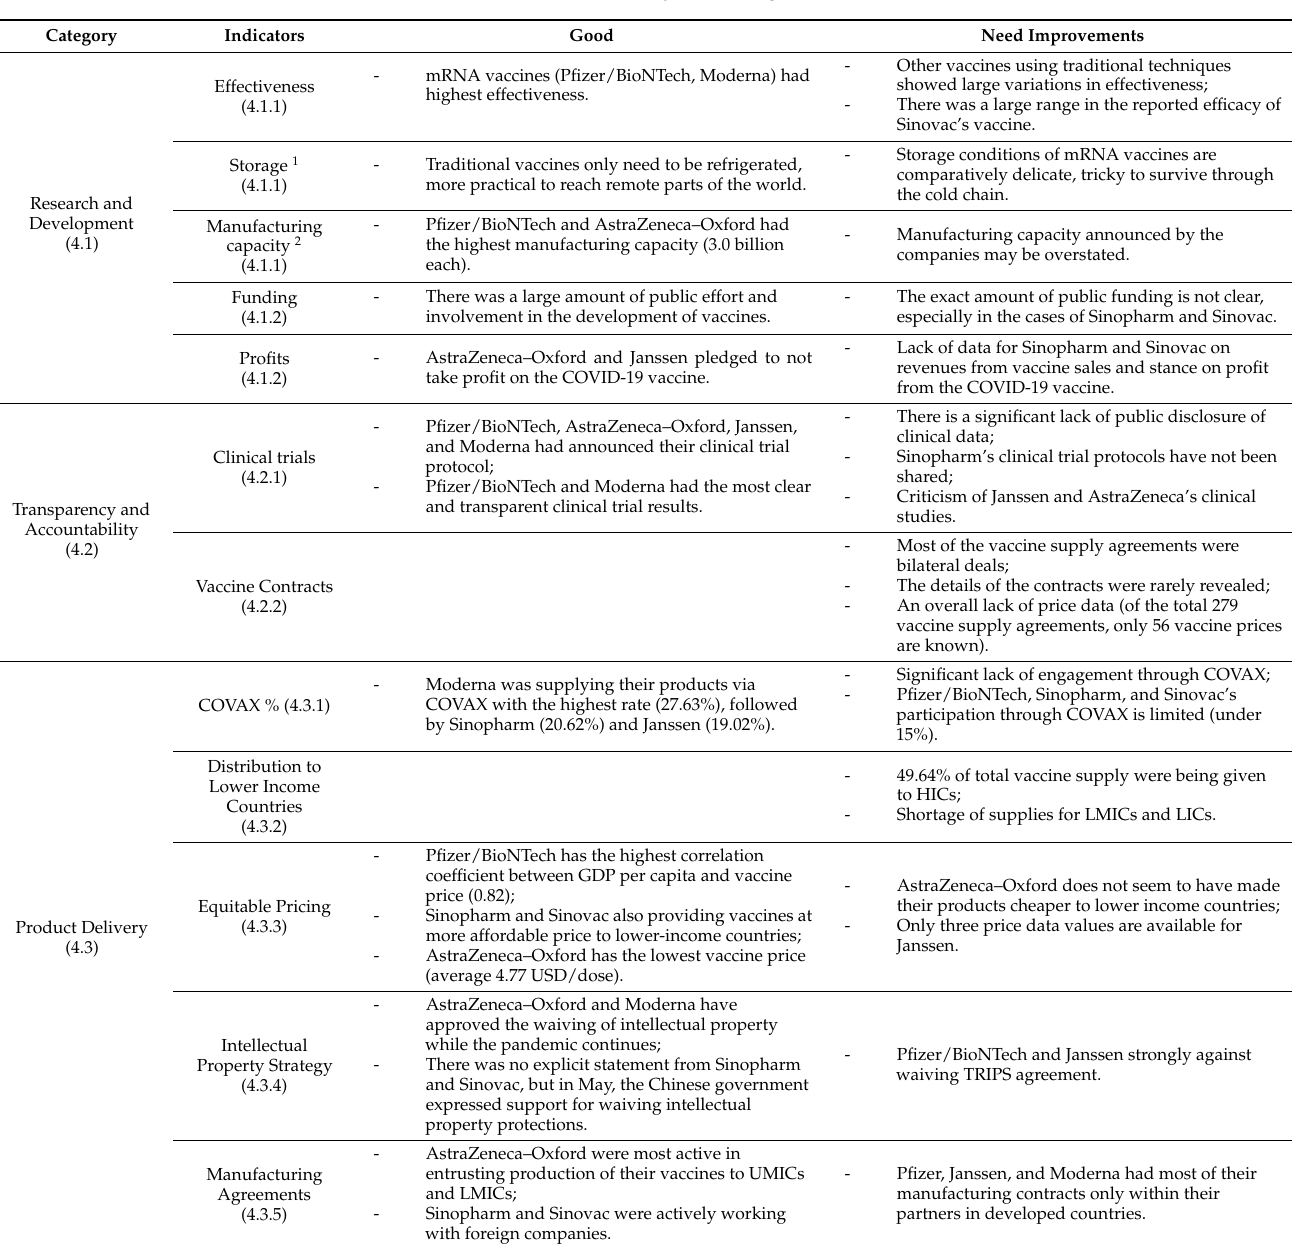
Table 7. Summary of